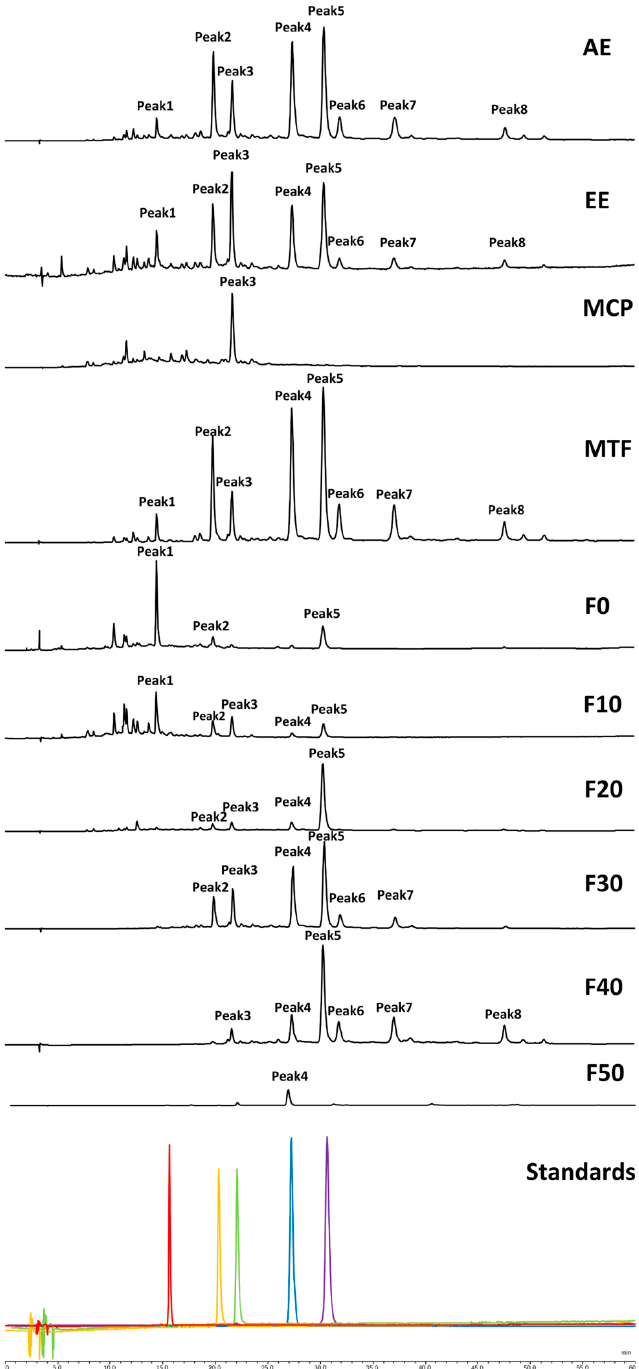
Figure 1. Components of MCB extracts and seven fractions investigated using HPLC. The used wavelength was 320 nm, peaks 1–6 were identified by comparison with authentic standard